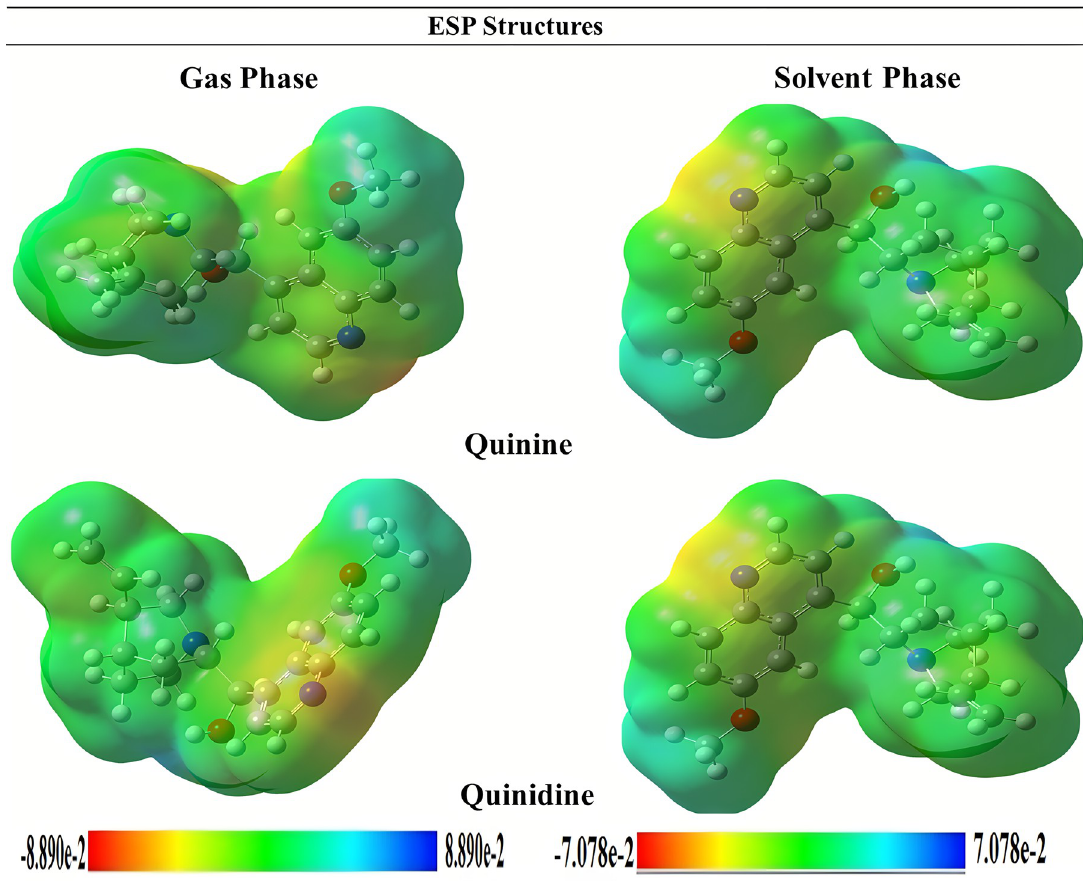
Fig 3. Molecular electrostatic potential (MEP) structures of quinolone derivatives in gas phase and solvent phase as well.